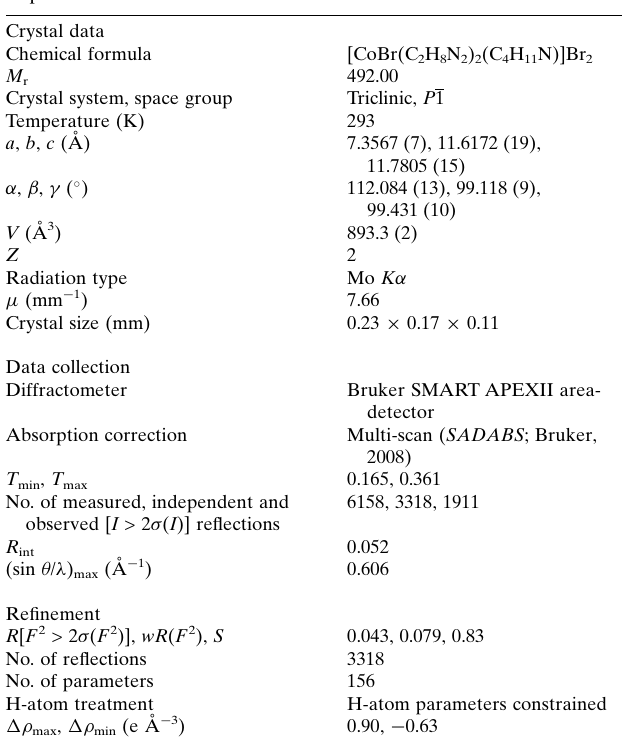
Table 2 Experimental details. Crystal data Chemical